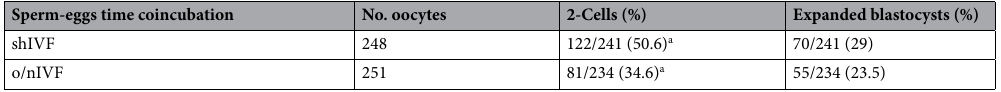
Table 2. Embryo development outcomes. Short IVF group showed significantly higher percentage of two-cells stage embryos and lower rate of oocytes not cleaved than overnight IVF group were higher in compared to overnight IVF. Values with similar superscript differs significantly ( P <